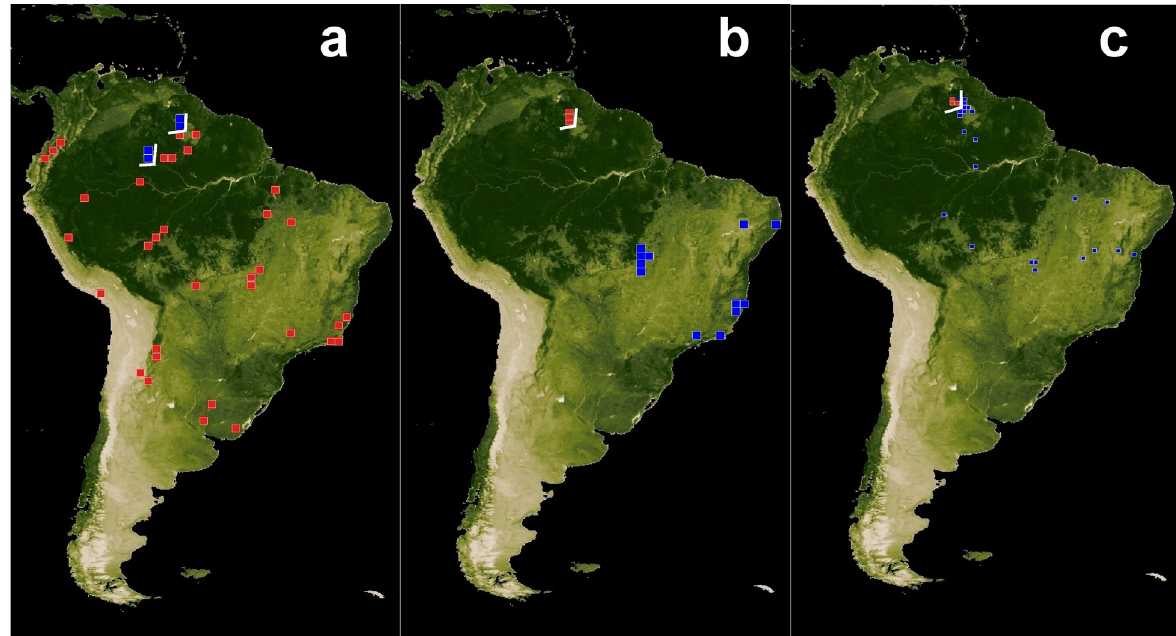
Figure 1 - SVe1 (Supported Vicariant event 1): ( a) Fittkauneuria (blue) and Oligoneuria (red); (b) Caenis tepuinensis (red) and Caenis cuniana (blue); (c) Spiritiops tepuinensis (red) and S. silvudus (blue). White lines are for visual reference (they are located in the same place in all the